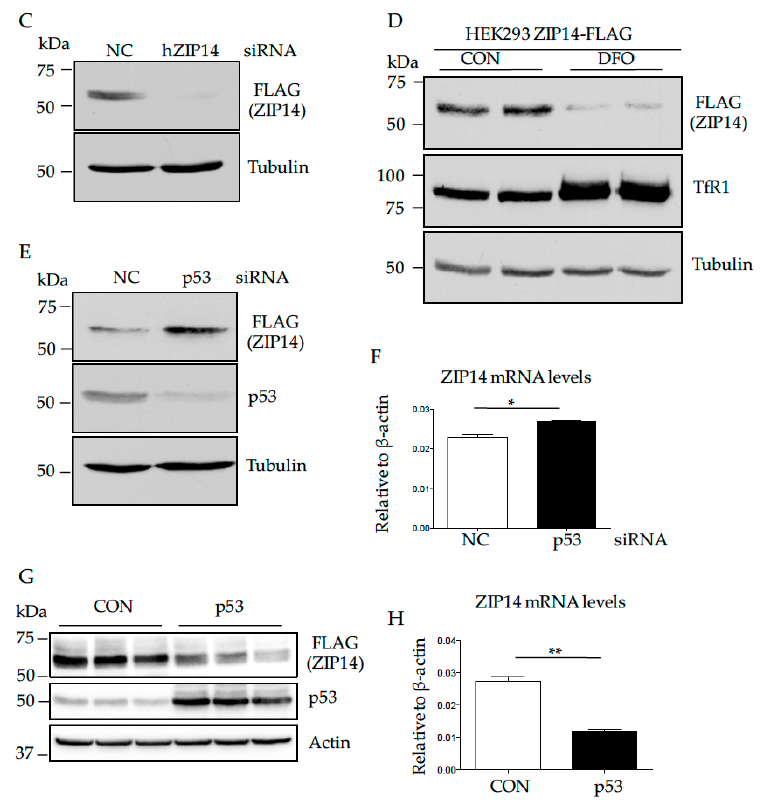
Figure 4. Knockdown of p53 increases endogenous ZIP14 protein level in human embryonic kidney HEK293 cells. We generated a derivative HEK293 cell line in which the endogenous ZIP14 locus was modified so as to incorporate a 3× FLAG tag at the ZIP14 C-terminus by using the Clustered Regularly Interspaced Short Palindromic Repeats (CRISPR)/CRISPR associated protein 9 (CRISPR/Cas9)-mediated genome editing approach (HEK293-ZIP14-FLAG cells). We design the single-stranded oligodeoxynucleotides (ssODN) to include about 50 bp of left and right homologous regions (HR) at each side of the ZIP14 stop codon, and the nucleotides encoding 3× FLAG sequence. ( A ) Schema for genotyping by PCR analysis: primer pair was designed to amplify a region of about 200 bp in length to cover the upstream and downstream area of ZIP14 ′ s stop codon. After ssODN mediated homologous recombination, the knock-in allele will have codons for 3× FLAG sequence, resulting in a PCR fragment of about 260 bp; ( B ) two single-guide RNA (sgRNA) were cloned into the px330 vector. PCR results demonstrate that both sgRNAs successfully lead to the knock-in of 3× FLAG sequence in HEK293 cells. We then identified single cell clones to establish the cell line as HEK293-ZIP14-FLAG cells and these cells were used from C to H; ( C ) cells were treated with ZIP14- targeting siRNAs for 48 h. Cells lysates were analyzed by immunoblotting for ZIP14. After stripping, blots were probed for tubulin as a loading control; ( D ) to confirm that endogenously tagged 3× FLAG ZIP14 in HEK293 cells retains its biological function and regulation, cells were treated with iron chelator desferrioxamine (DFO) (100 µM) for 24 h to induce iron deficiency. Cell lysates were analyzed by immunoblotting for ZIP14. After stripping, blots were probed for TfR1 as an iron treatment control and tubulin as a loading control; ( E ) cells were transfected with p53- targeting siRNA for 48 h. Cell lysates were analyzed by immunoblotting for ZIP14. After stripping, blots were probed for p53 and tubulin; ( F ) transcript levels of ZIP14 after p53 siRNA treatment were measured and normalized to those of β -actin. Data represents three independent experiments with consistent results. NC: negative control; ( G ) cells were transfected with an empty pCMV (CON) or pCMV-p53 vector for 48 h. Cell lysates were analyzed by immunoblotting; ( H ) transcript levels of ZIP14 after p53 overexpression were measured and normalized to those of β -actin. Data represents two independent experiments with consistent results. NC: universal scrambled negative control siRNA. * p < 0.05, ** p < 0.001, compared with